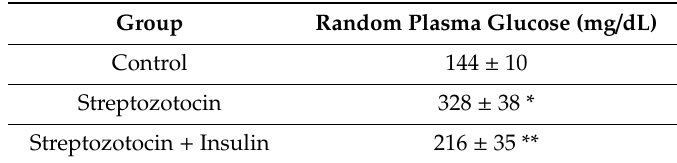
Table 1. Plasma glucose levels measured 24 h post-Femoral Artery Ligation prior to sacrifice ( n = 7 in each